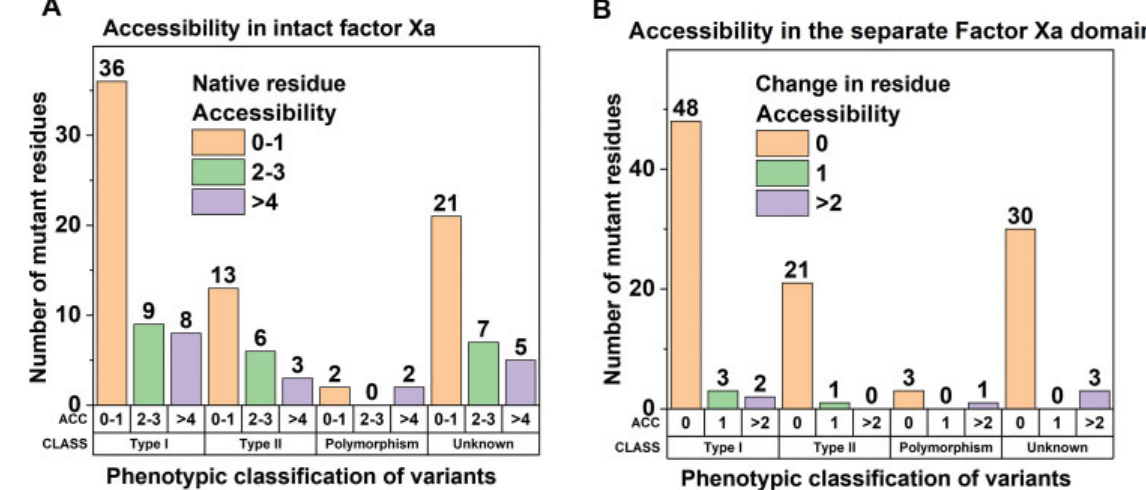
Fig. 8 Accessibility analyses of 108 FX missense variants and four polymorphisms in the factor X (FX) protein structure. ( A ) FX variants in the FXa structure are grouped by phenotypic classi fi cation (CLASS). The variants are further subdivided according to the native residue accessibility (ACC) of the intact protein. Accessibility was determined using the De fi nition of Secondary Structure of Proteins (DSSP) and is explained in detail in the Methods section. Accessibilities of 0 or 1 indicate sidechain burial and values > 1 indicate sidechain exposure to solvent. ( B ) FX variants are again grouped by phenotypic classi fi cation (CLASS) and accessibility (ACC). Here, accessibility refers to the change in residue accessibility when the intact FX protein is separated into its four distinct domains, namely, the γ -carboxyglutamic acid (GLA), epidermal growth factor (EGF)-1, EGF-2, and serine protease (SP)